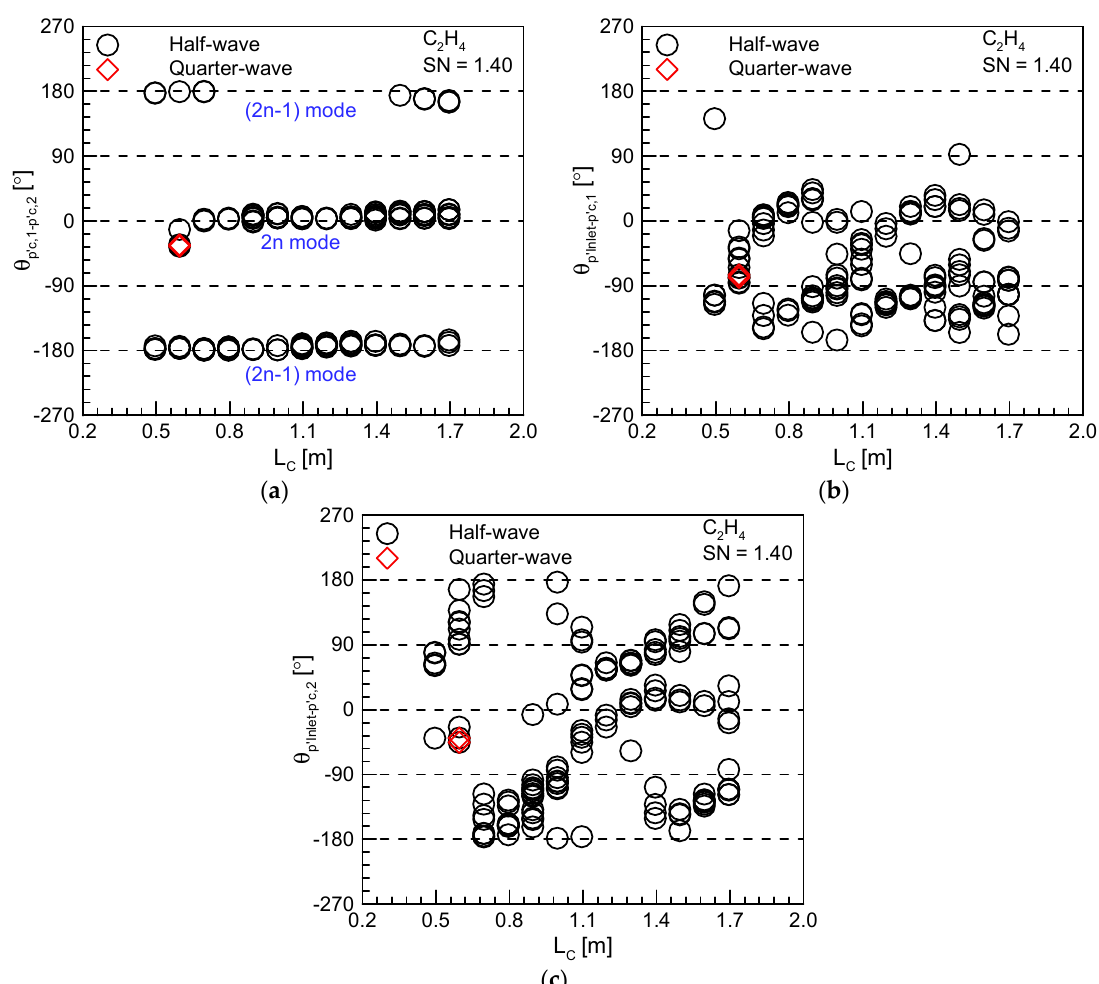
Figure 11. Phase difference as a function of the combustion chamber length using C 2 H 4 at SN = 1.40: ( a ) θ p (cid:48) , ( b ) θ p (cid:48) , and ( c ) θ p (cid:48) . − p (cid:48) − p (cid:48) − p (cid:48) C ,1 C ,2 Inlet C ,1 Inlet C ,2